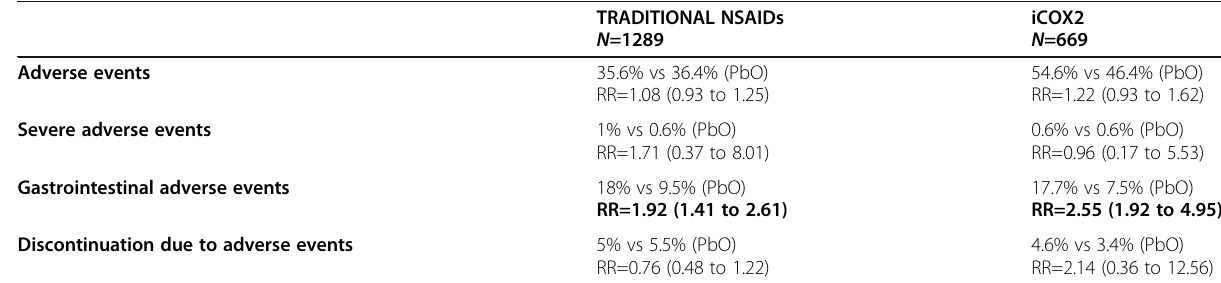
TRADITIONAL NSAIDs N =1289